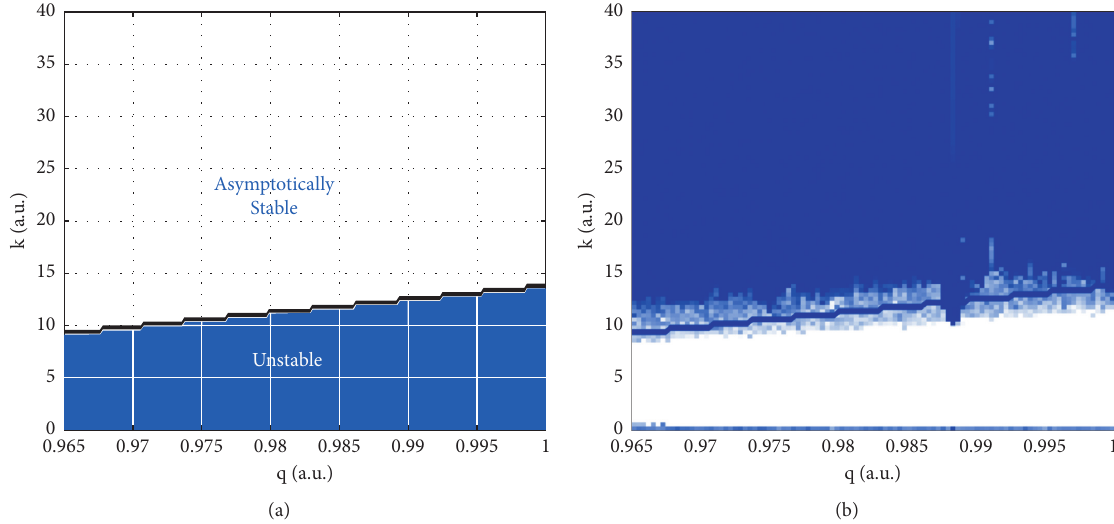
Figure 9: (a) Stability analysis from linear error dynamics for the coupled Chua system as shown in equation (29). (b) Overlay of the analytical result in the synchronization map as shown in Figure 8(a).